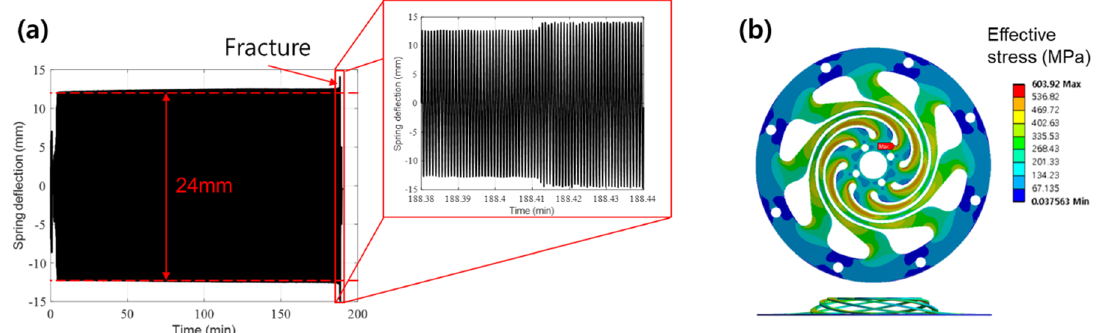
Figure 20. ( a ) Fatigue test measured at 12 mm spring displacement, and ( b ) structural stress analysis at 12 mm displacement.